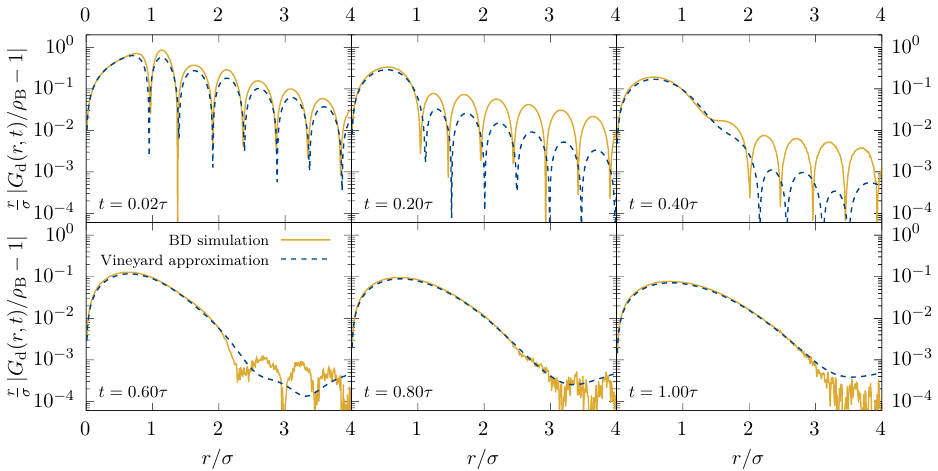
( r , t ) , obtained directly d